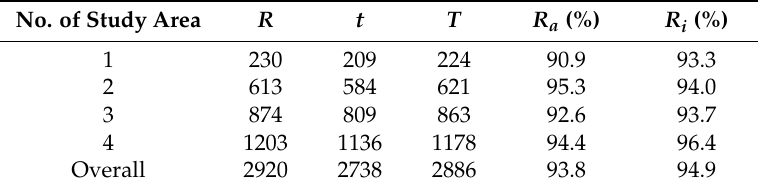
Table 6. Detection results of change type in different study